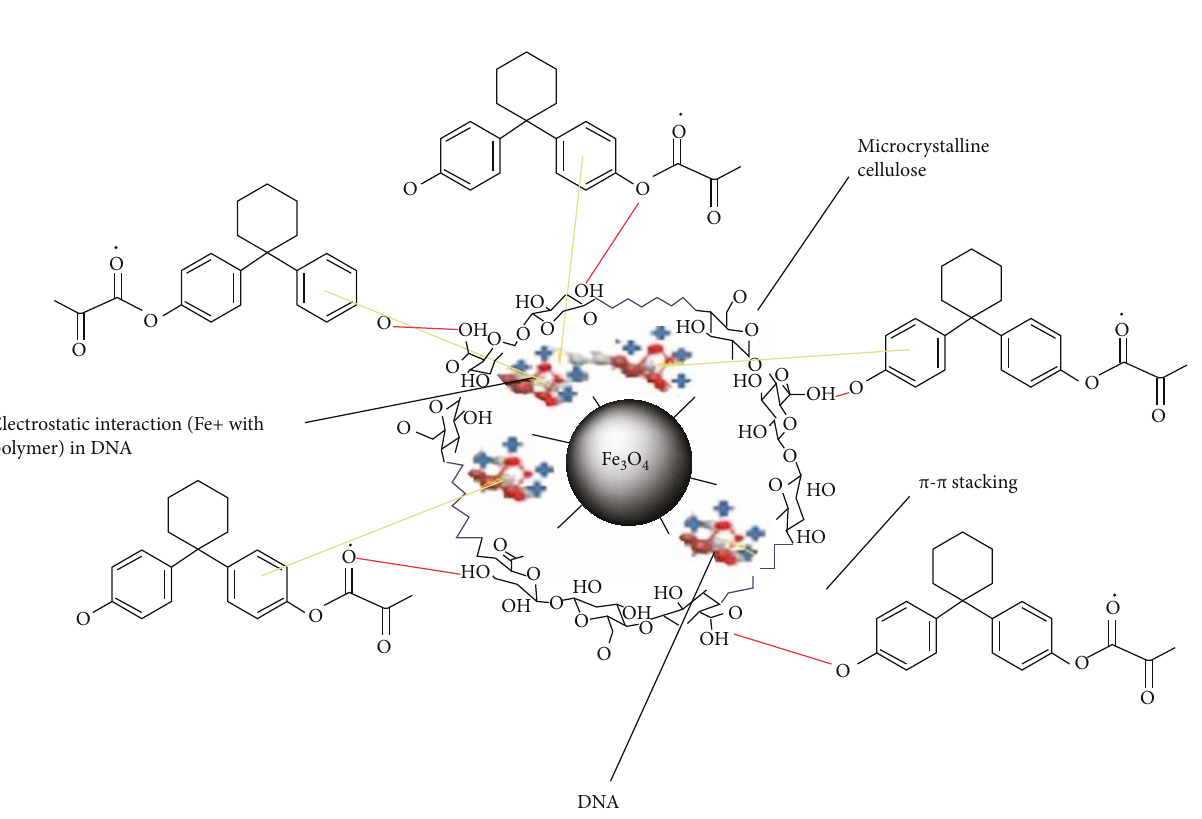
Figure 6: Schematic representation of the mechanism of adsorption and desorption of DNA onto the poly(4,4 ′ -cyclohexylidene bisphenol oxalate)-MCC-Fe O composite. 3 4